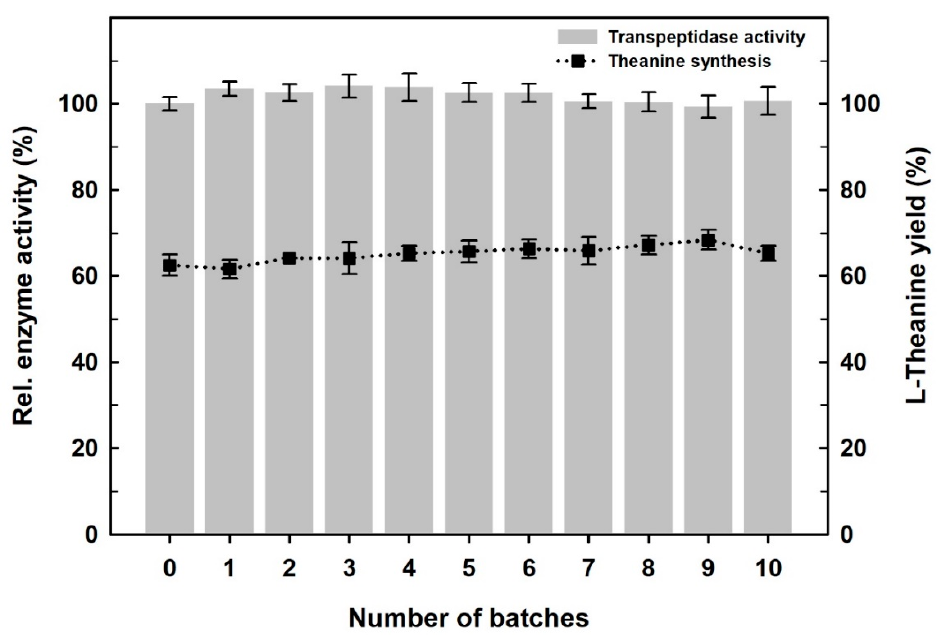
Figure 8. Reusability of N450D-mCLEAs as monitored by activity assay (left scale) and the synthesis of L -theanine (right scale). The data are the average of three independent experiments with standard deviations.